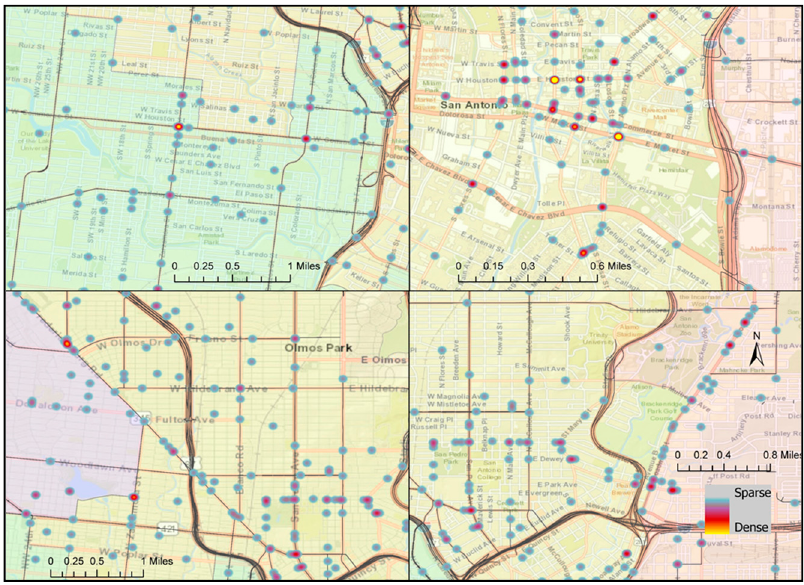
Figure 2. Locations with frequent bicycle crashes: intersection at W Commerce St and Zarzamora St ( top left ), intersections in the city center ( top right ), intersection at Fredericksburg Rd and San Pedro Ave ( bottom left ), and intersection at Broadway St and W Ashby Pl ( bottom right ).